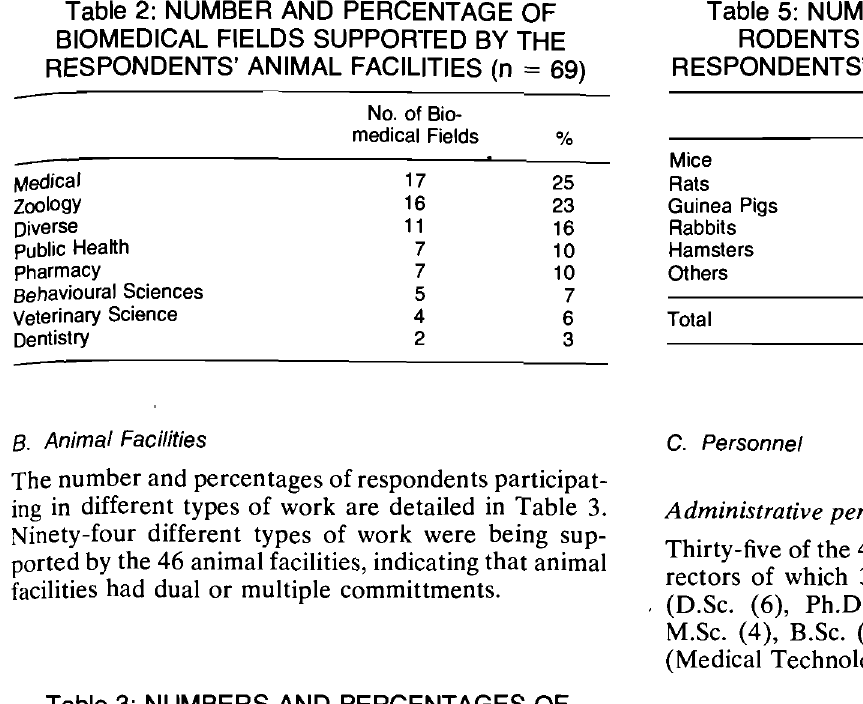
Table 3: NUMBERS AND PERCENTAGES OF